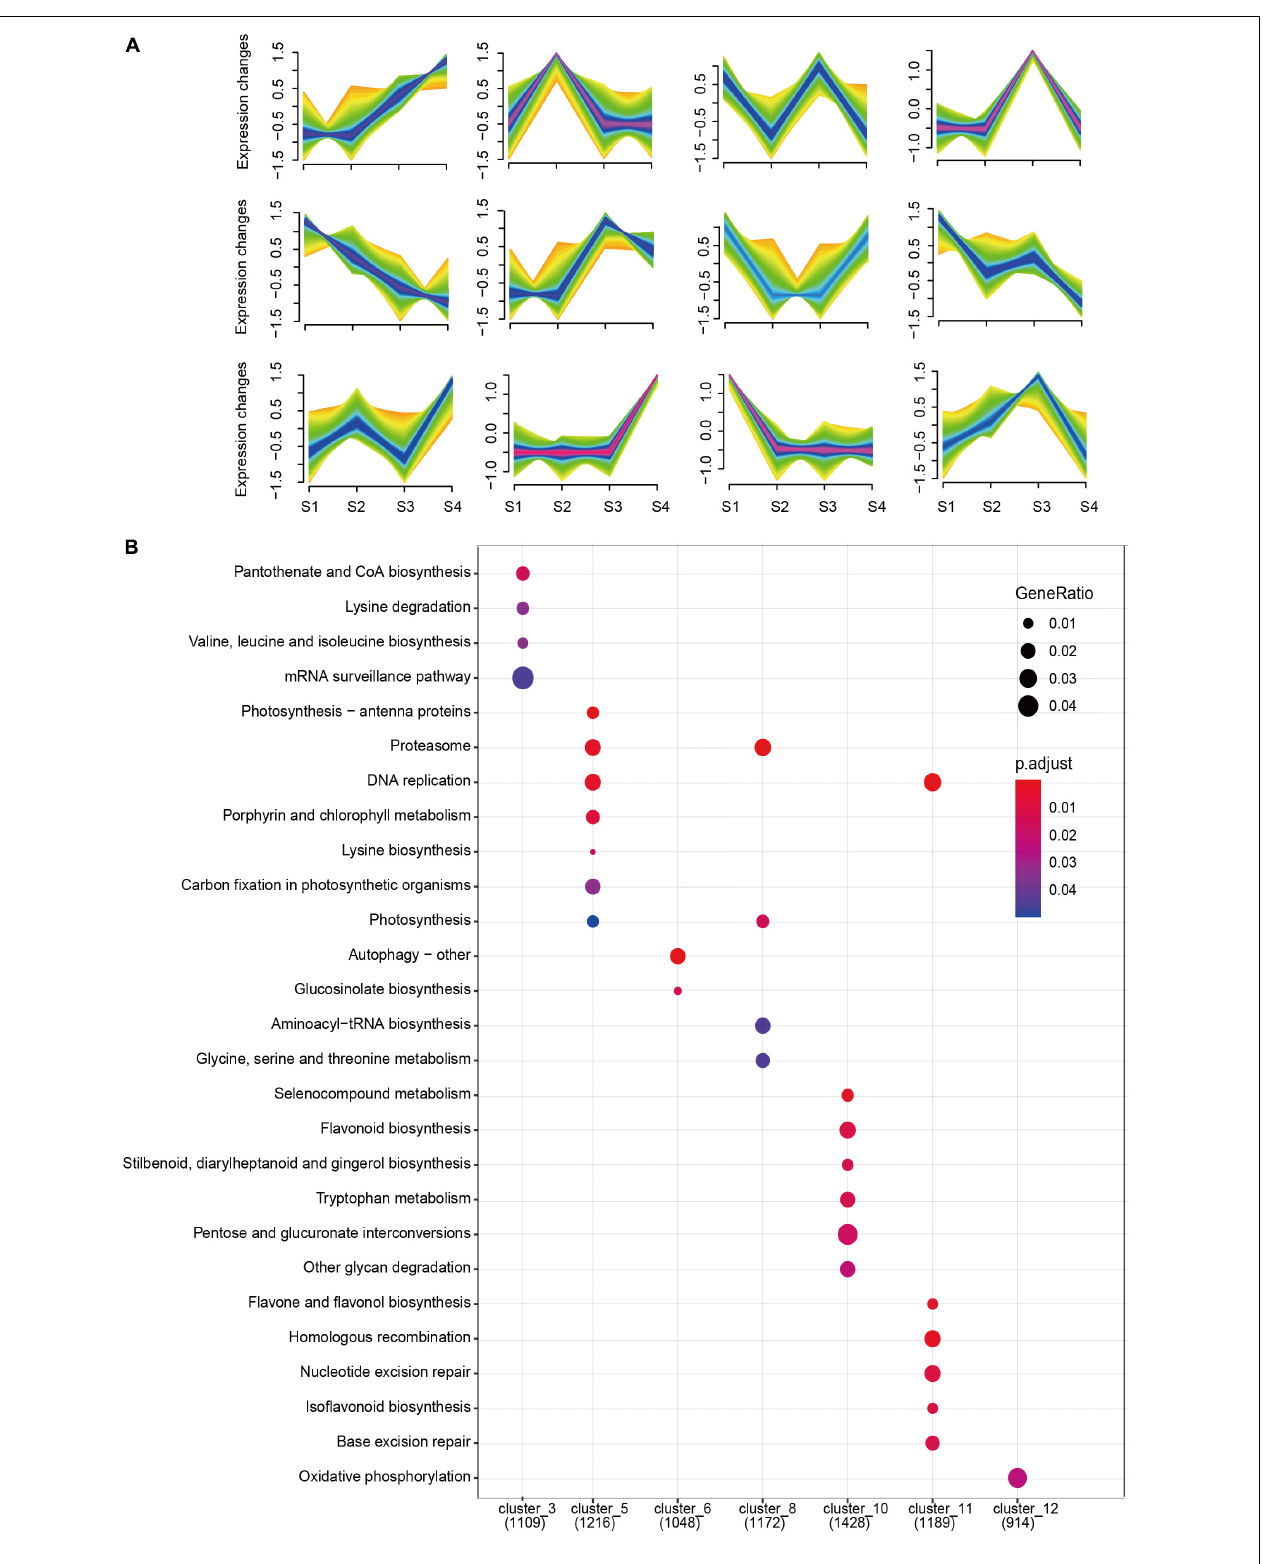
FIGURE 3 | Analysis of 12 time-series clusters during stigma development of hickory. (A) Clustering analysis of gene expression patterns at different time points using fuzzy c-means algorithm (Mfuzz). (B) Kyoto Encyclopedia of Genes and Genomes (KEGG) analysis of 12 clusters.